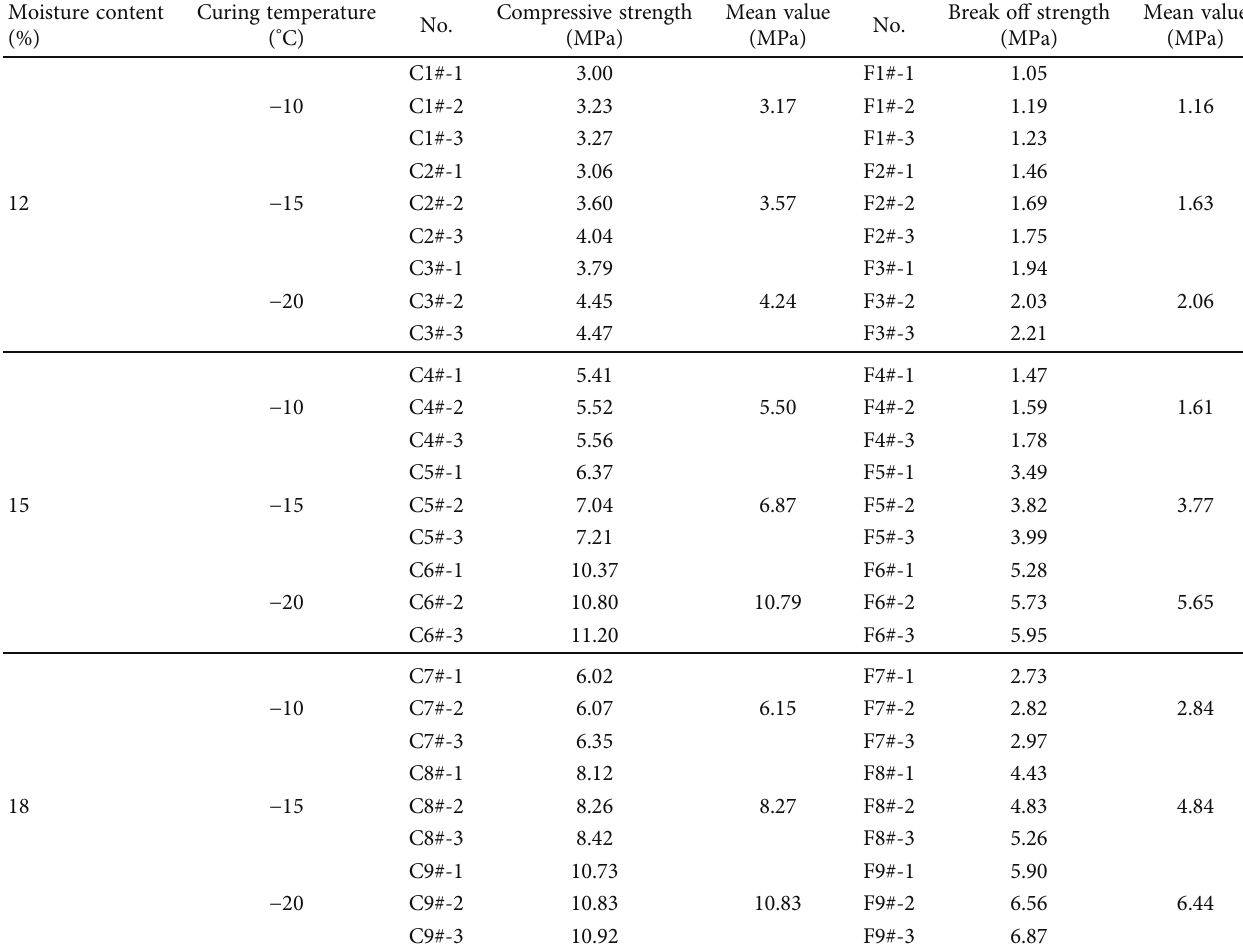
Table 1: Test results of mechanical properties of arti fi cial frozen